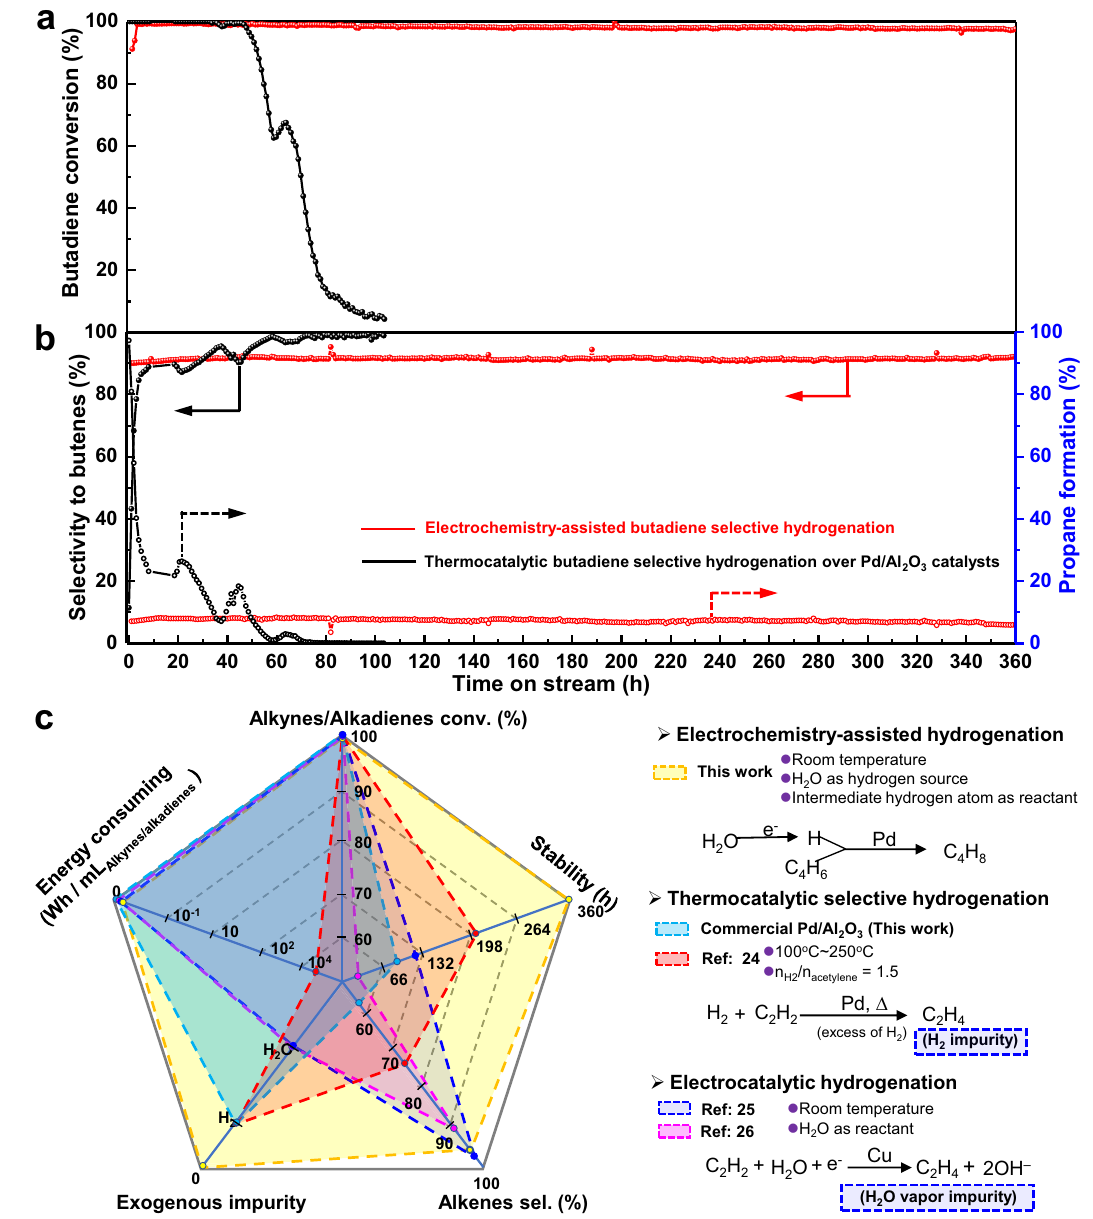
Fig. 3 | Catalytic stability comparison between the electrochemical-assisted selective hydrogenation and the hydrogenation on commercial Pd/Al 2 O 3 cat- alyst. a Butadiene conversion and b selectivity to butenes and propane formation as a function of time on stream by electrochemistry-assisted selective hydrogena- tion strategy (current density= − 15mAcm − 2 , electrolyte fl ow rate=5mLmin − 1 and GHSV=5308h − 1 , at 25~30°C, with 0.6% butadiene and 6% propene in helium